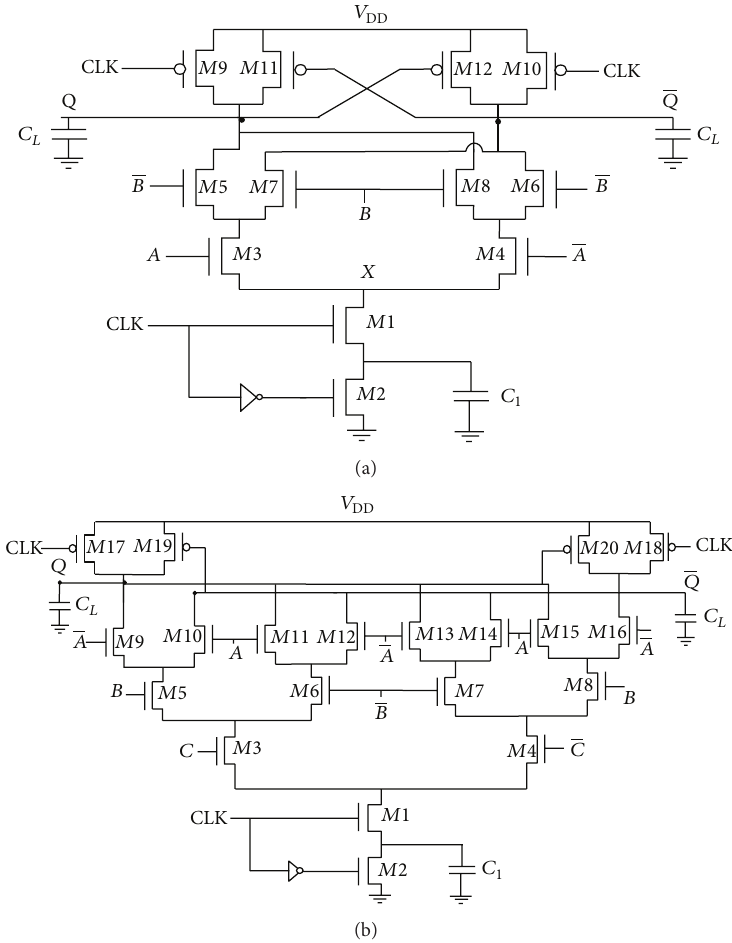
Figure 2: DyCML gate: (a) two-input XOR; (b) three-input XOR.